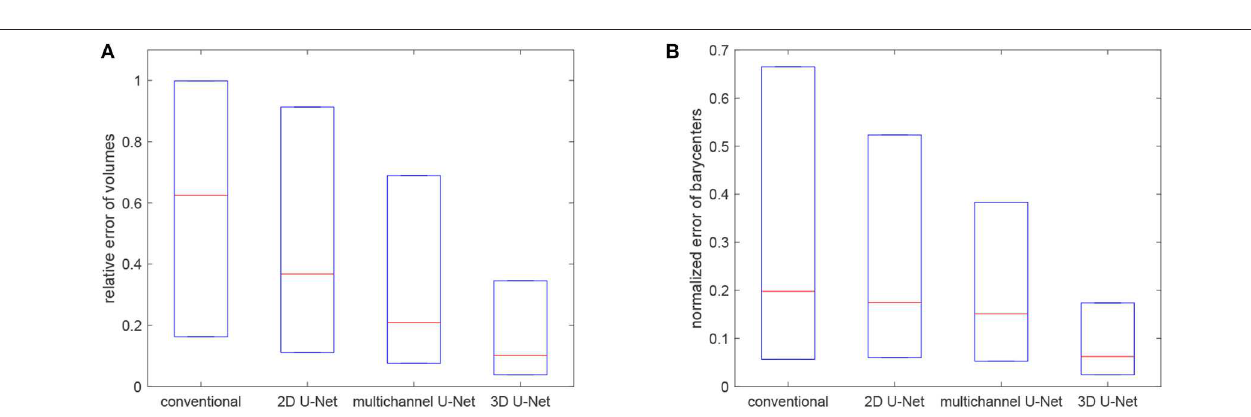
with a size of 80 × 80 × 80 voxels. Since these cutouts cover relatively small volumes, see Figure 6A , they do not provide the necessary size for learning large scale features with the 3D